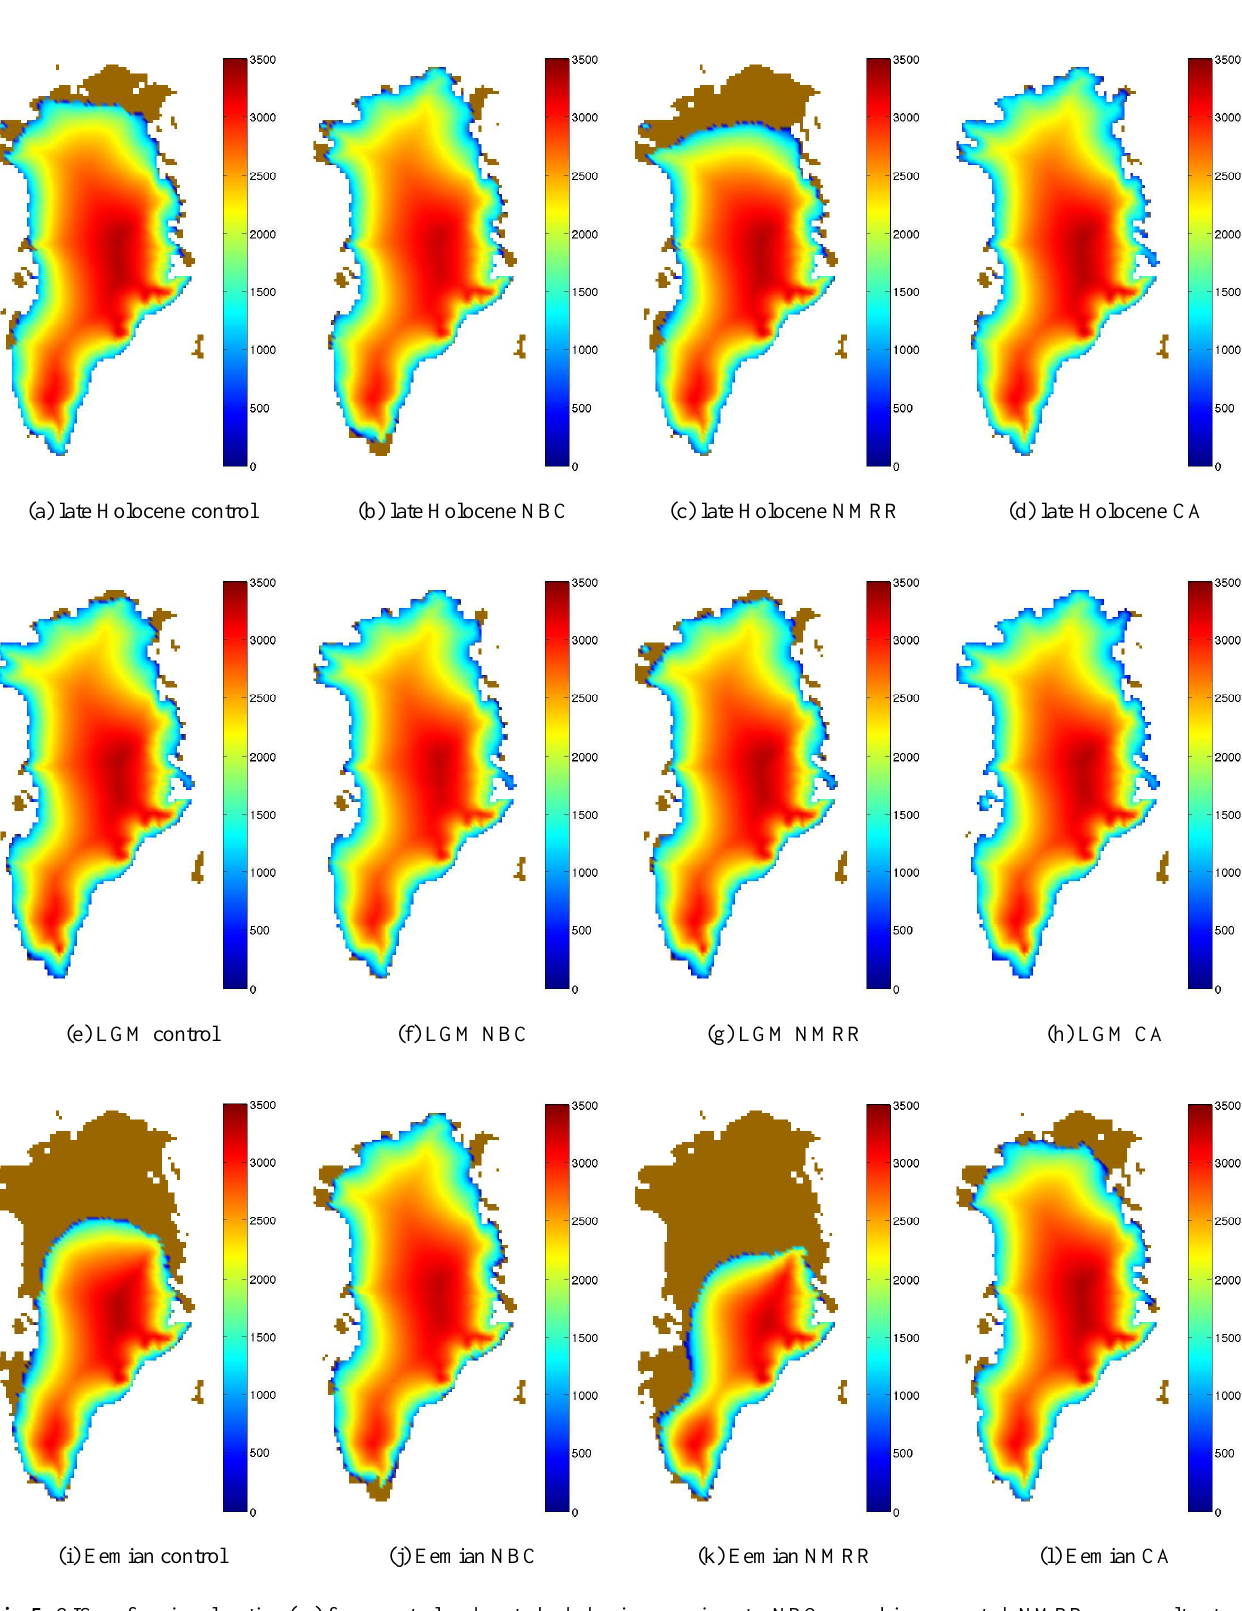
Fig. 8: GIS surface ice elevation (m) from control and perturbed physics experiments. NBC=non-bias-corrected, NMRR=non-meltwater-retention or refreezing, CA=constant albedo.